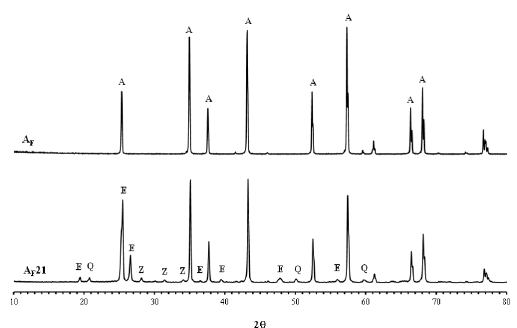
and composite A 21. A: F F ), Z: ZrO . Alumina A 2 2 F